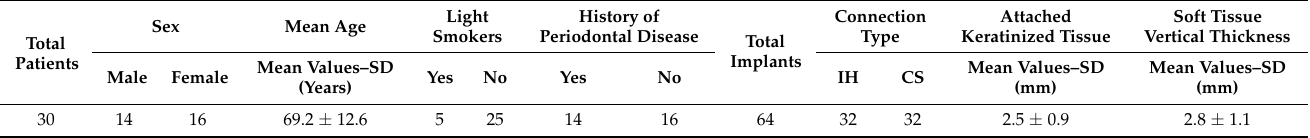
Table 3. Intragroup differences in mean bone loss. (* statistically significant).